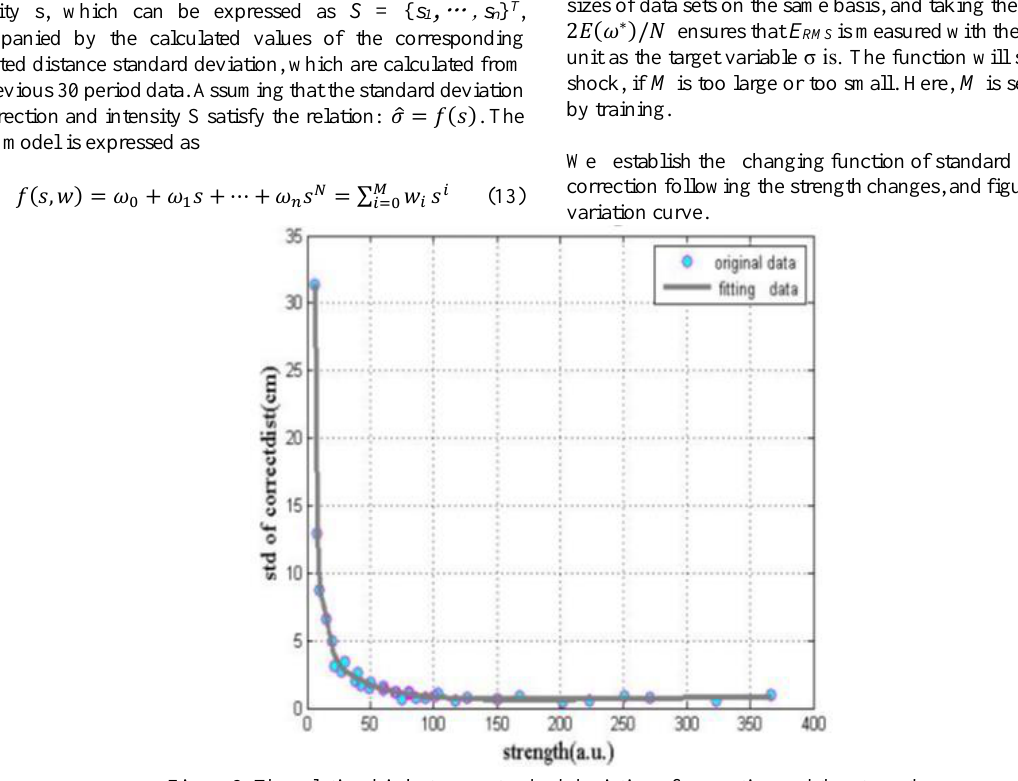
Figure 2. The relationship between standard deviation of correction and the strength